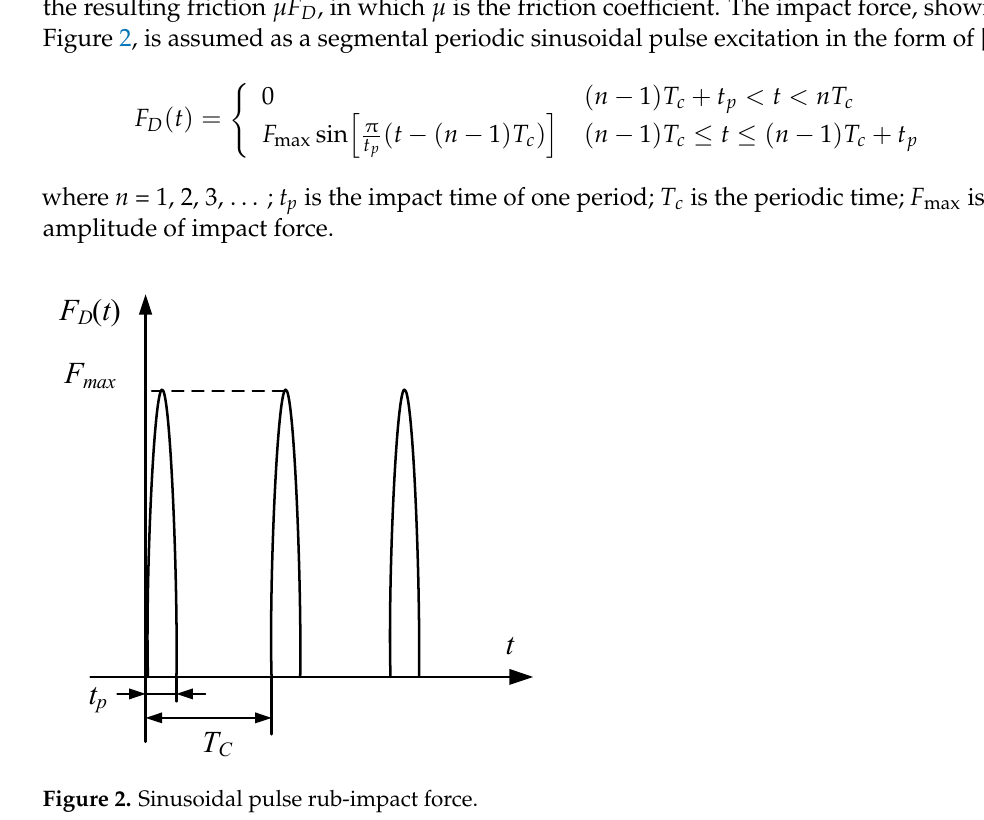
Figure 2. Sinusoidal pulse rub-impact force .